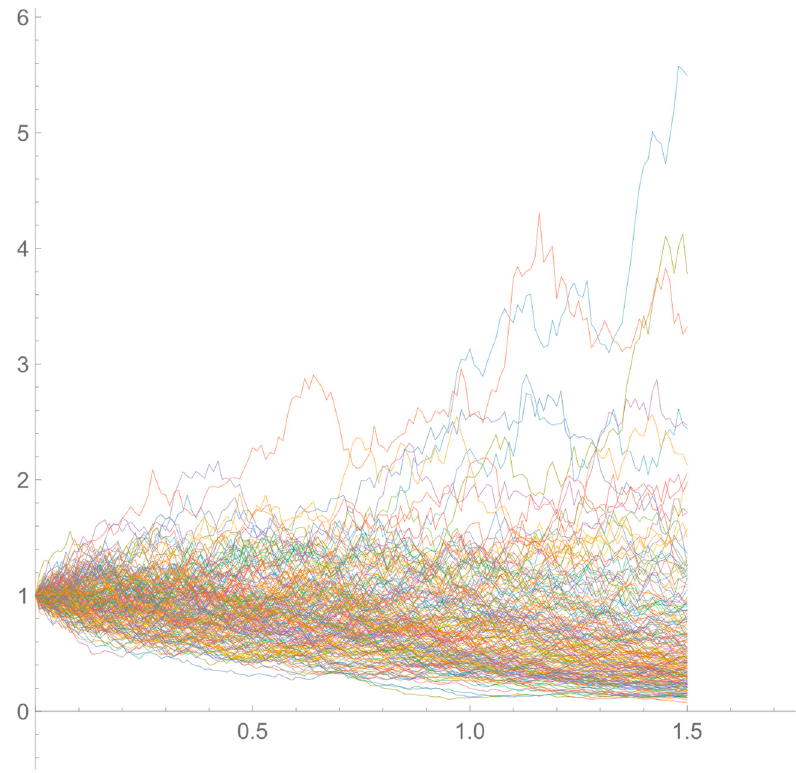
Figure 2. The sample paths for the optimal debt ratio with hidden fiscal multipliers and hidden credit risk premia.